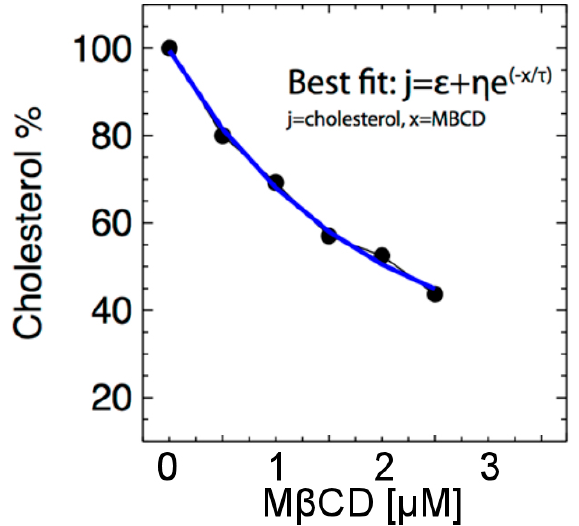
parameter β and δ have the optimal values of the p -value and reduced chi-square for │ b/ δ b │ >> 1, thus, the hypothesis of MßCD dependence is accepted.